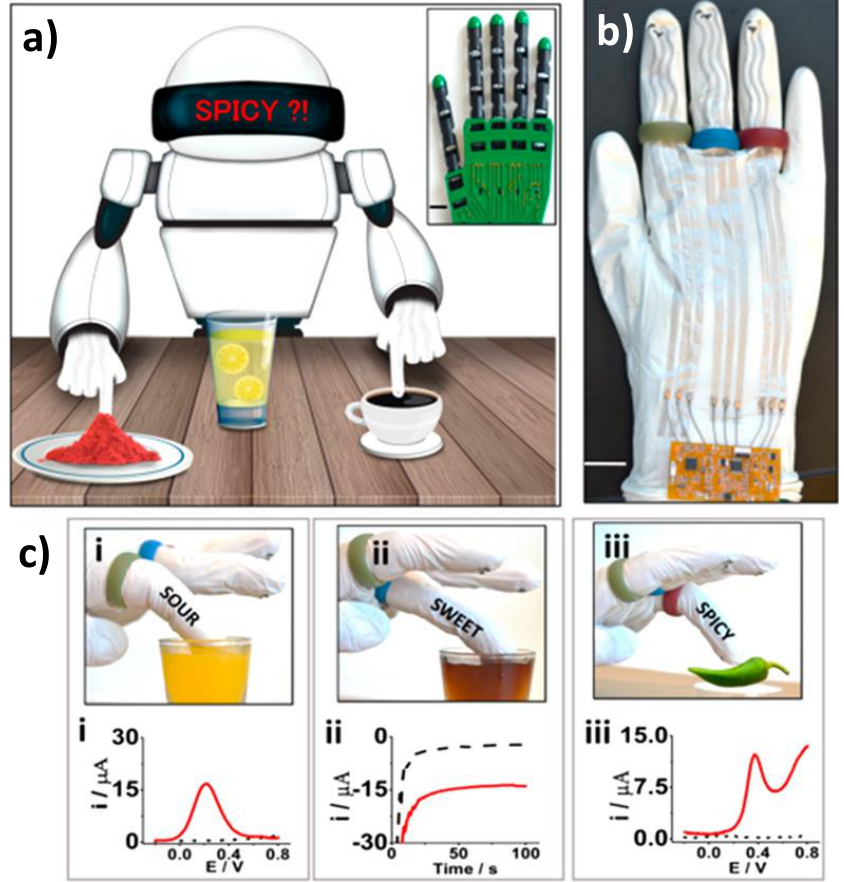
Figure 12. Automated taste discrimination in food samples through chemical sensing at the robot fingertips ( a ) Prototype of the screen-printed robotic sense fingers (carbon-printed sour-finger in green, GOx PB-printed sweet-finger in blue and carbon-printed spicy-finger in red) with long connections to the electronic interface ( b ). Images and corresponding electrochemical responses (in red) of: robotic sour-finger dipped in orange juice and the square wave voltammetry (SWV) signature of ascorbic acid (i), robotic sweet-finger in cherry juice and amperometry data of glucose (ii), spicy-finger on green-pepper, and SWV feedback response to the presence of capsaicin (iii). For comparison purposes the response obtained in phosphate buffer saline (PBS) response are displayed in black dotted lines ( c ). Reprinted and adapted with permission of American Chemical Society [72].